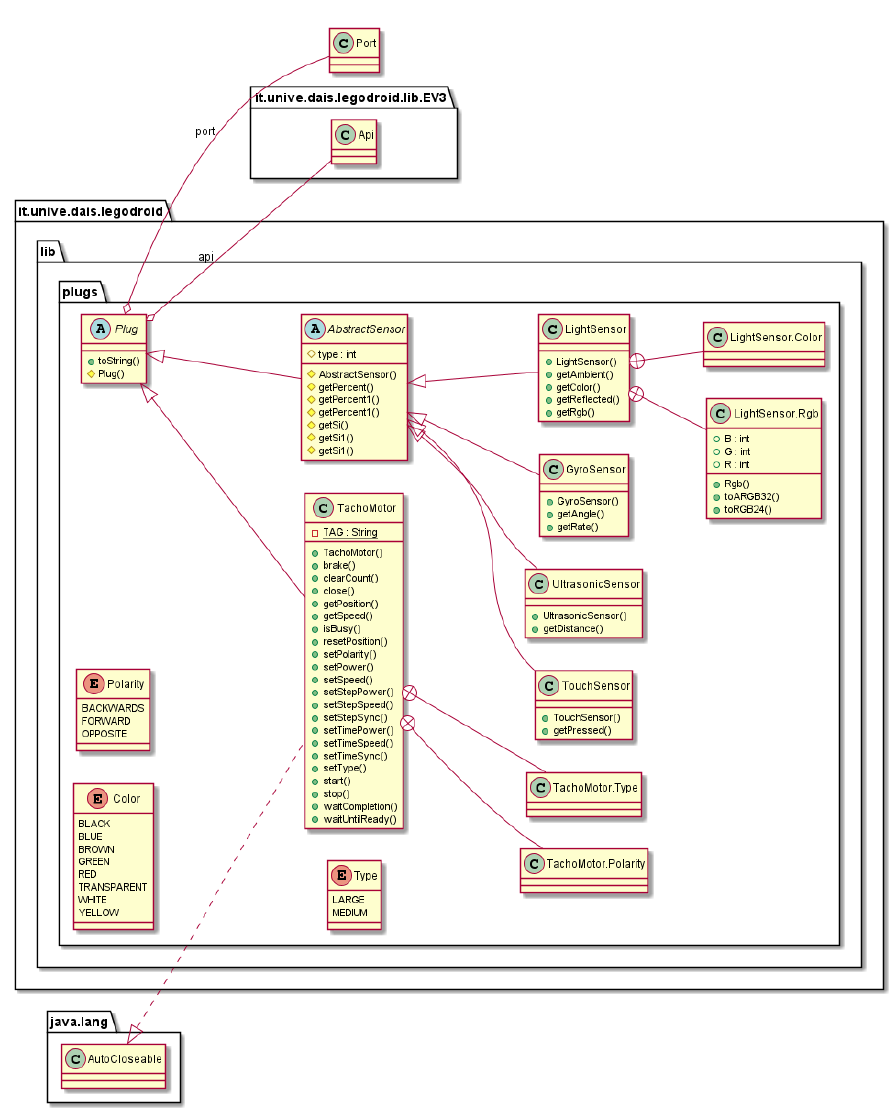
Figure 4. UML Class Diagram of package legodroid.lib.plugs